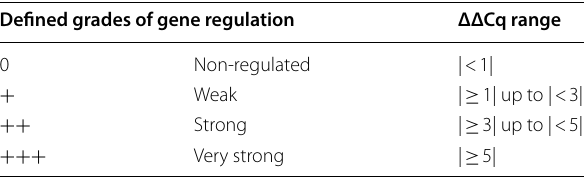
The grades of gene regulation are given as follows: “0” for non-regulated, “ weakly regulated, “ ” for strongly regulated, “ ++